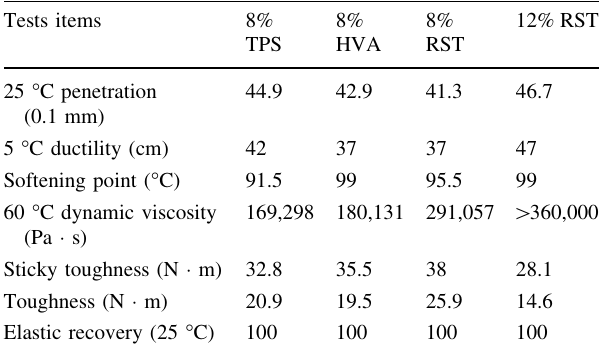
Table 10 B-type SBS asphalt binder high-viscosity performance